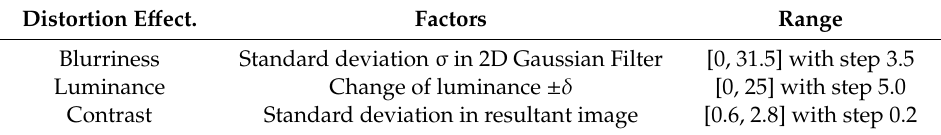
Table 8. Parameters used to generate distortions of the retinal images for agreement grade evaluation. Distortion E ff ect. Factors